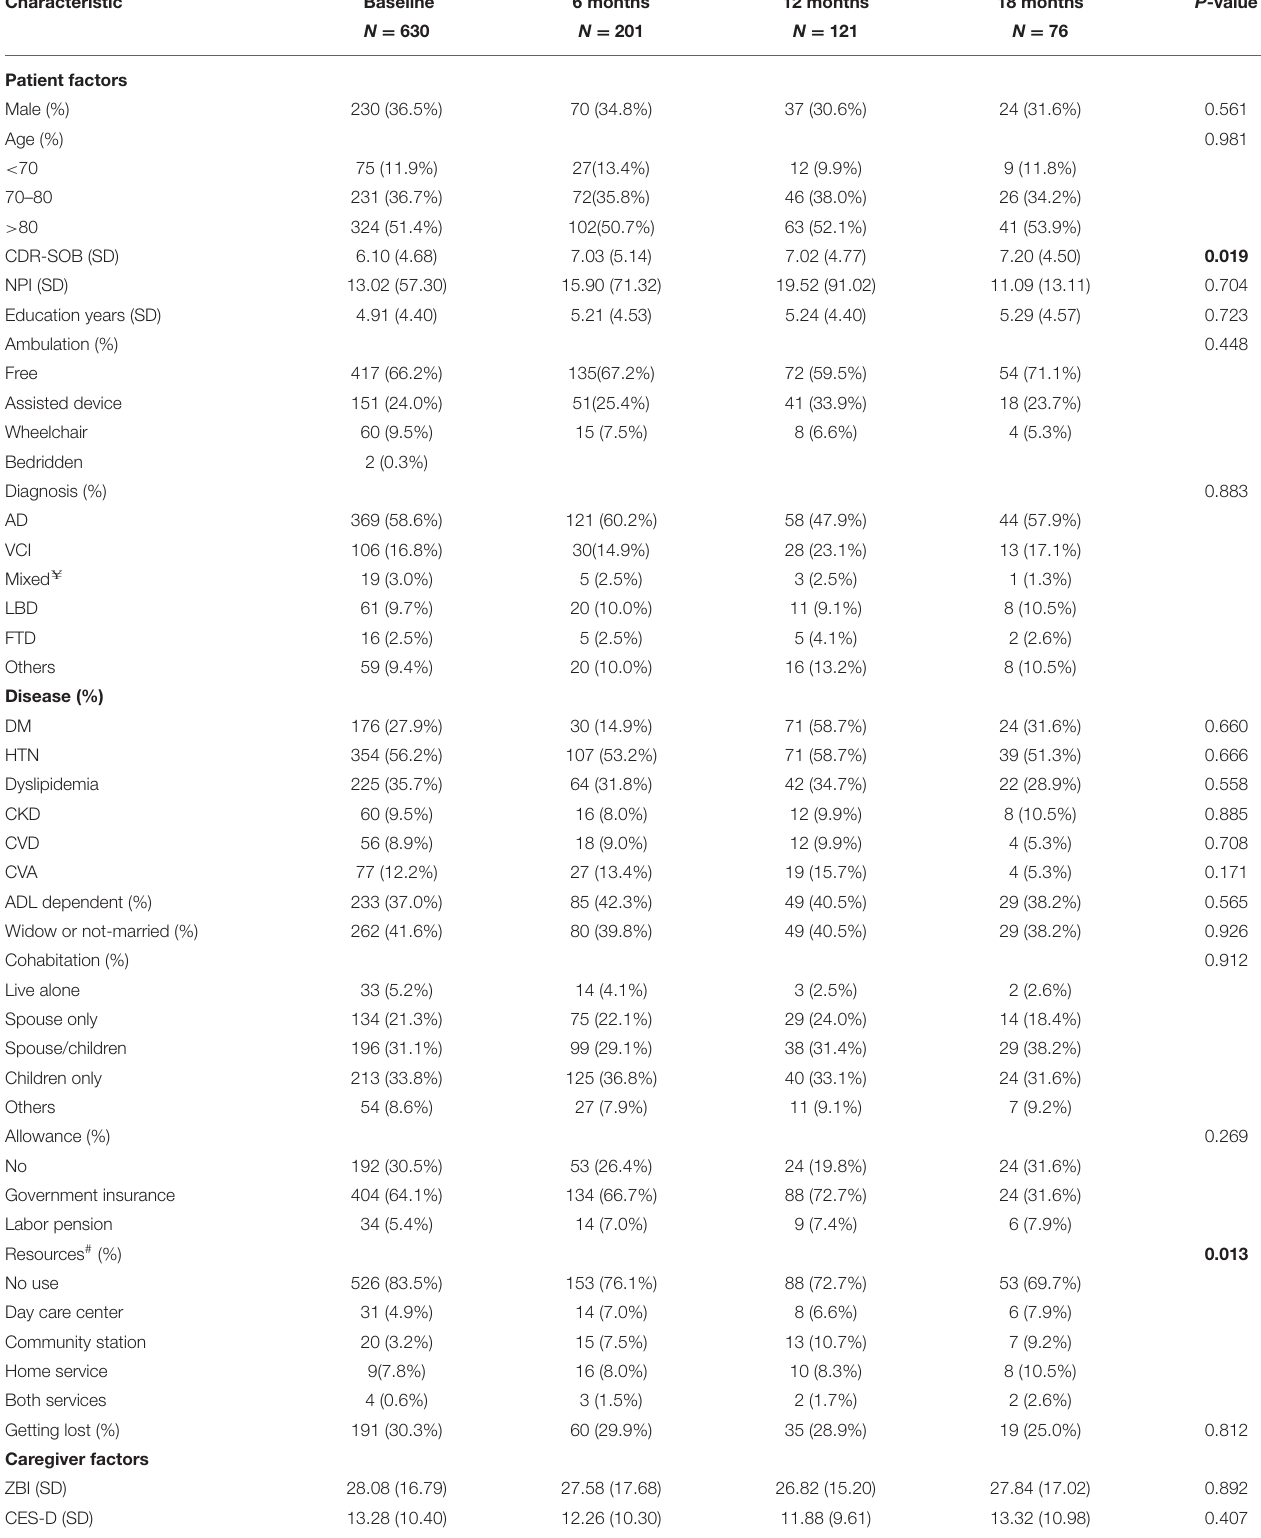
TABLE 1 | Characteristics of patients and caregivers at baseline and follow-up.